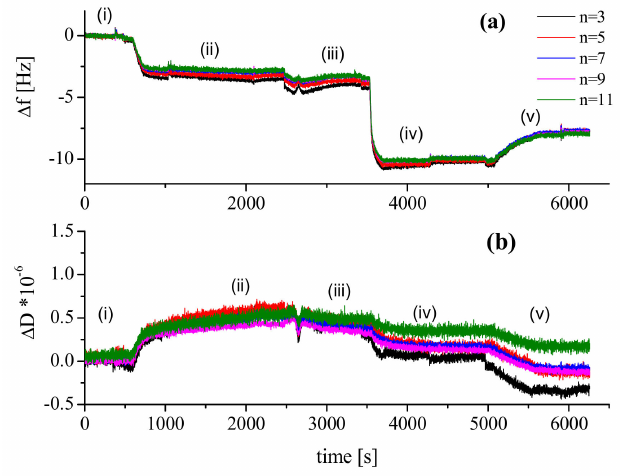
Figure 3. Time dependence of ( a ) the frequency ( ∆ f ) and ( b ) dissipation ( ∆ D ) shifts. The raw data are normalised for the overtone number. Numbers of overtones are presented in the